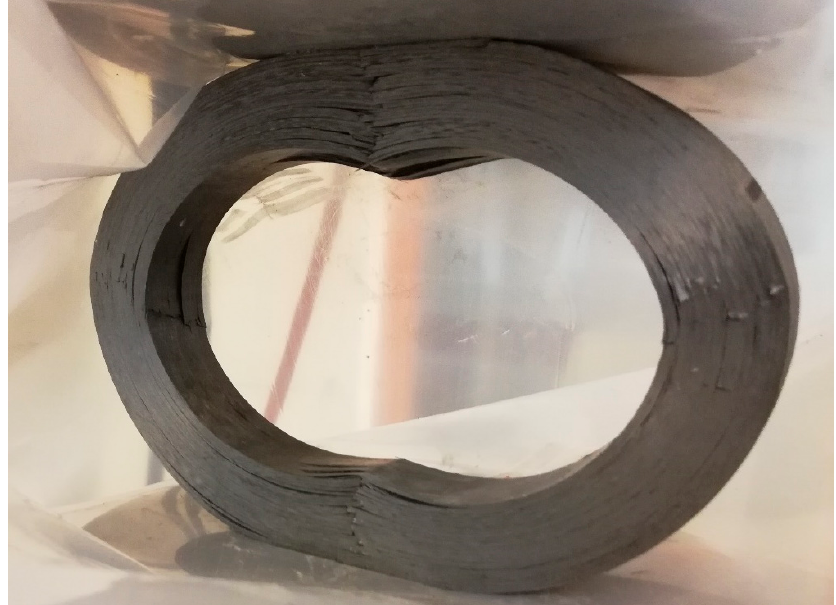
Figure 14. Composite ring after radial compression test.